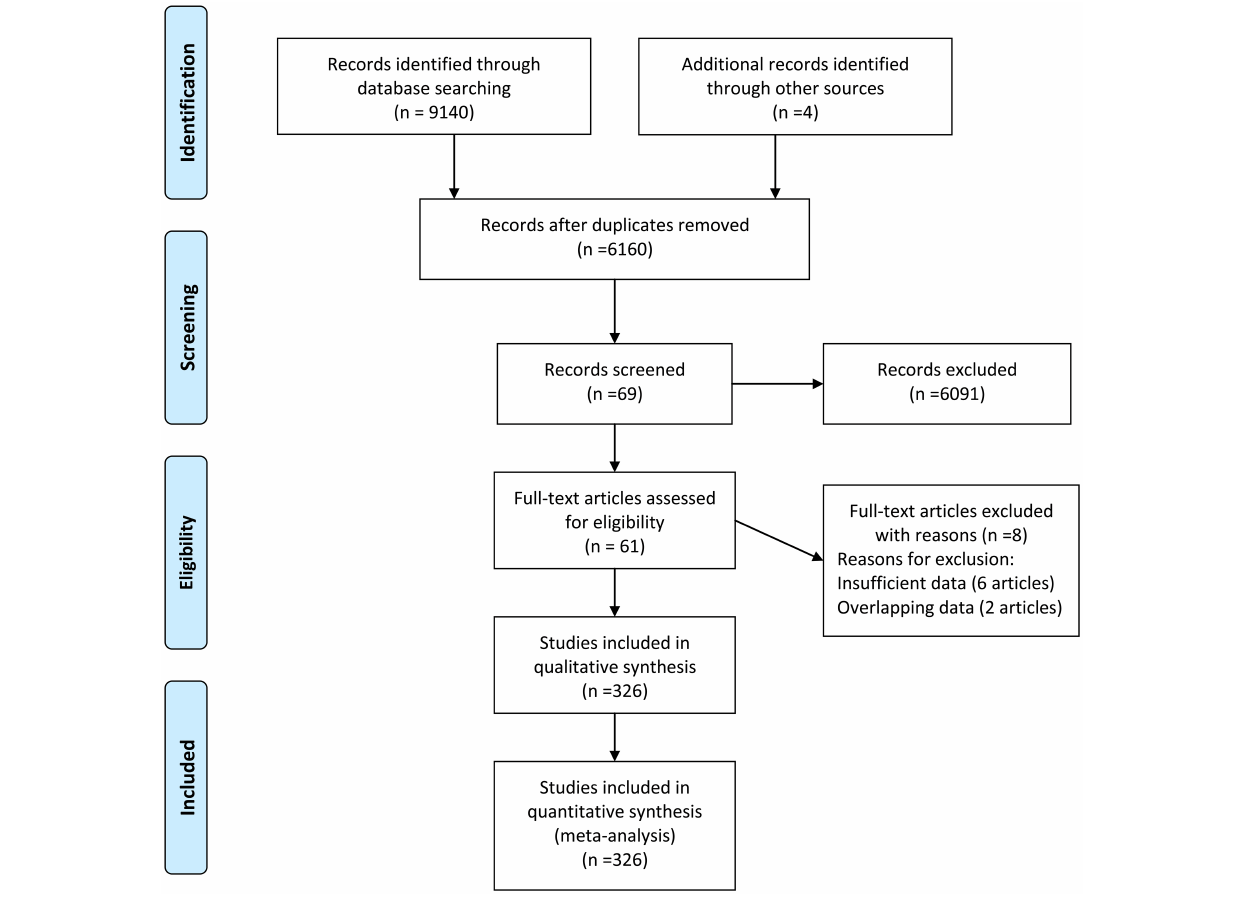
FIGURE 1 | Flow diagram of study